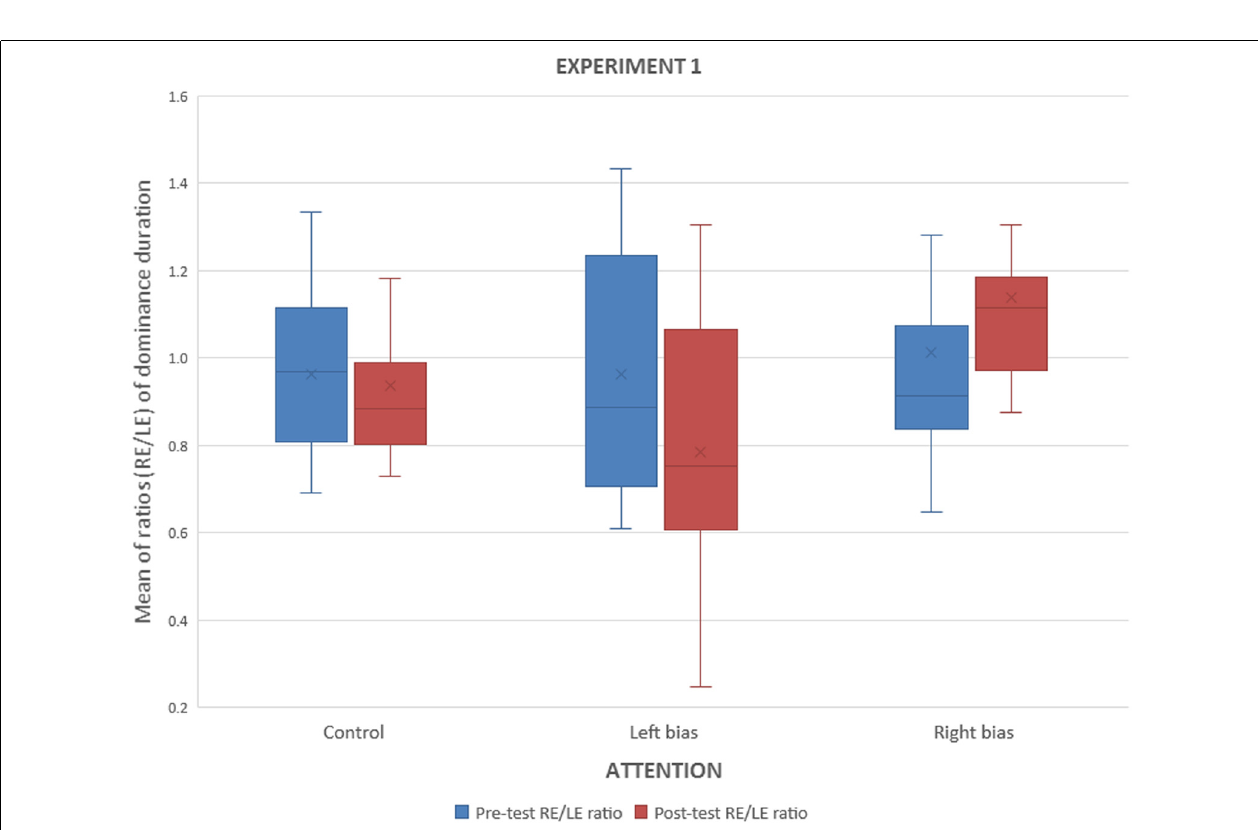
FIGURE 3 | Experiment 1. Interocular ratios (right/left) of median dominance durations before and after the monocular counting task.